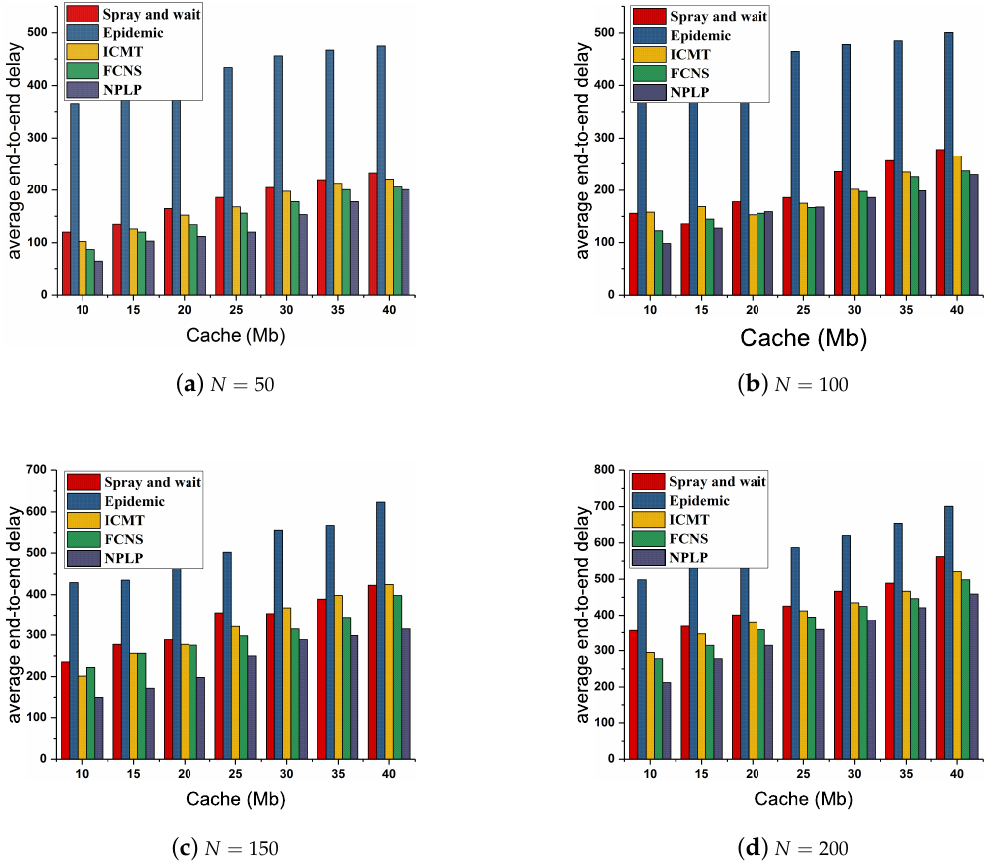
Figure 5. Performance comparison of average end-to-end delay between five algorithms with various cache spaces and various number of